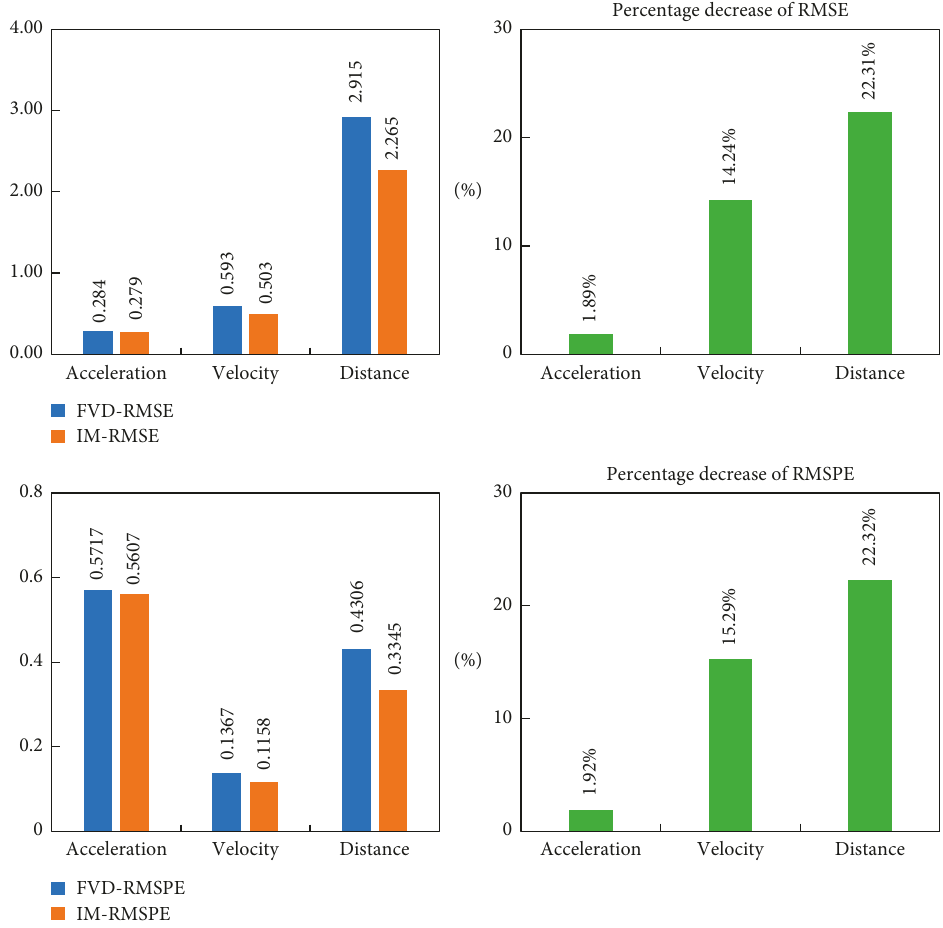
Figure 14: Performance of proposed car-following model. Note: IM is improved